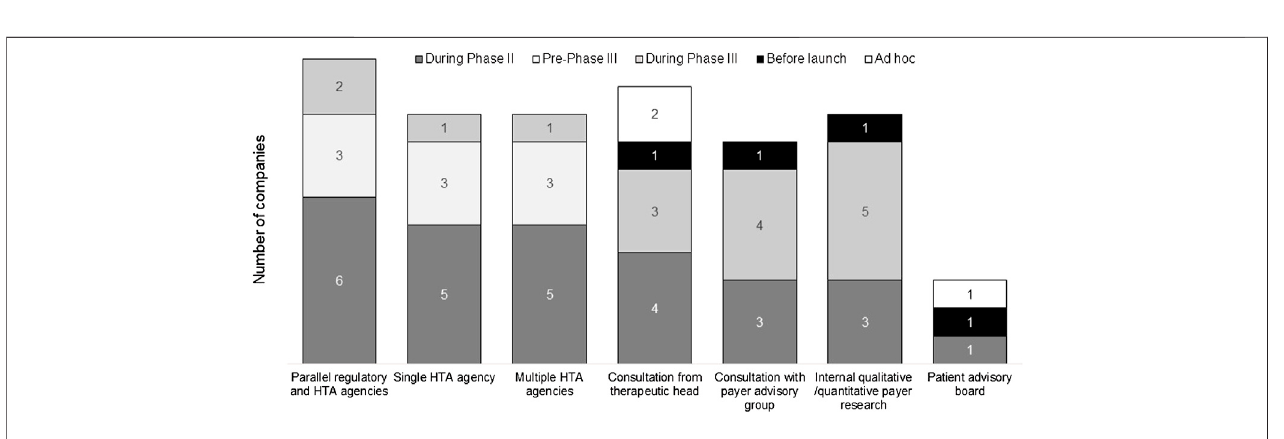
FIGURE 4 | Stakeholder engagement strategy to test the value